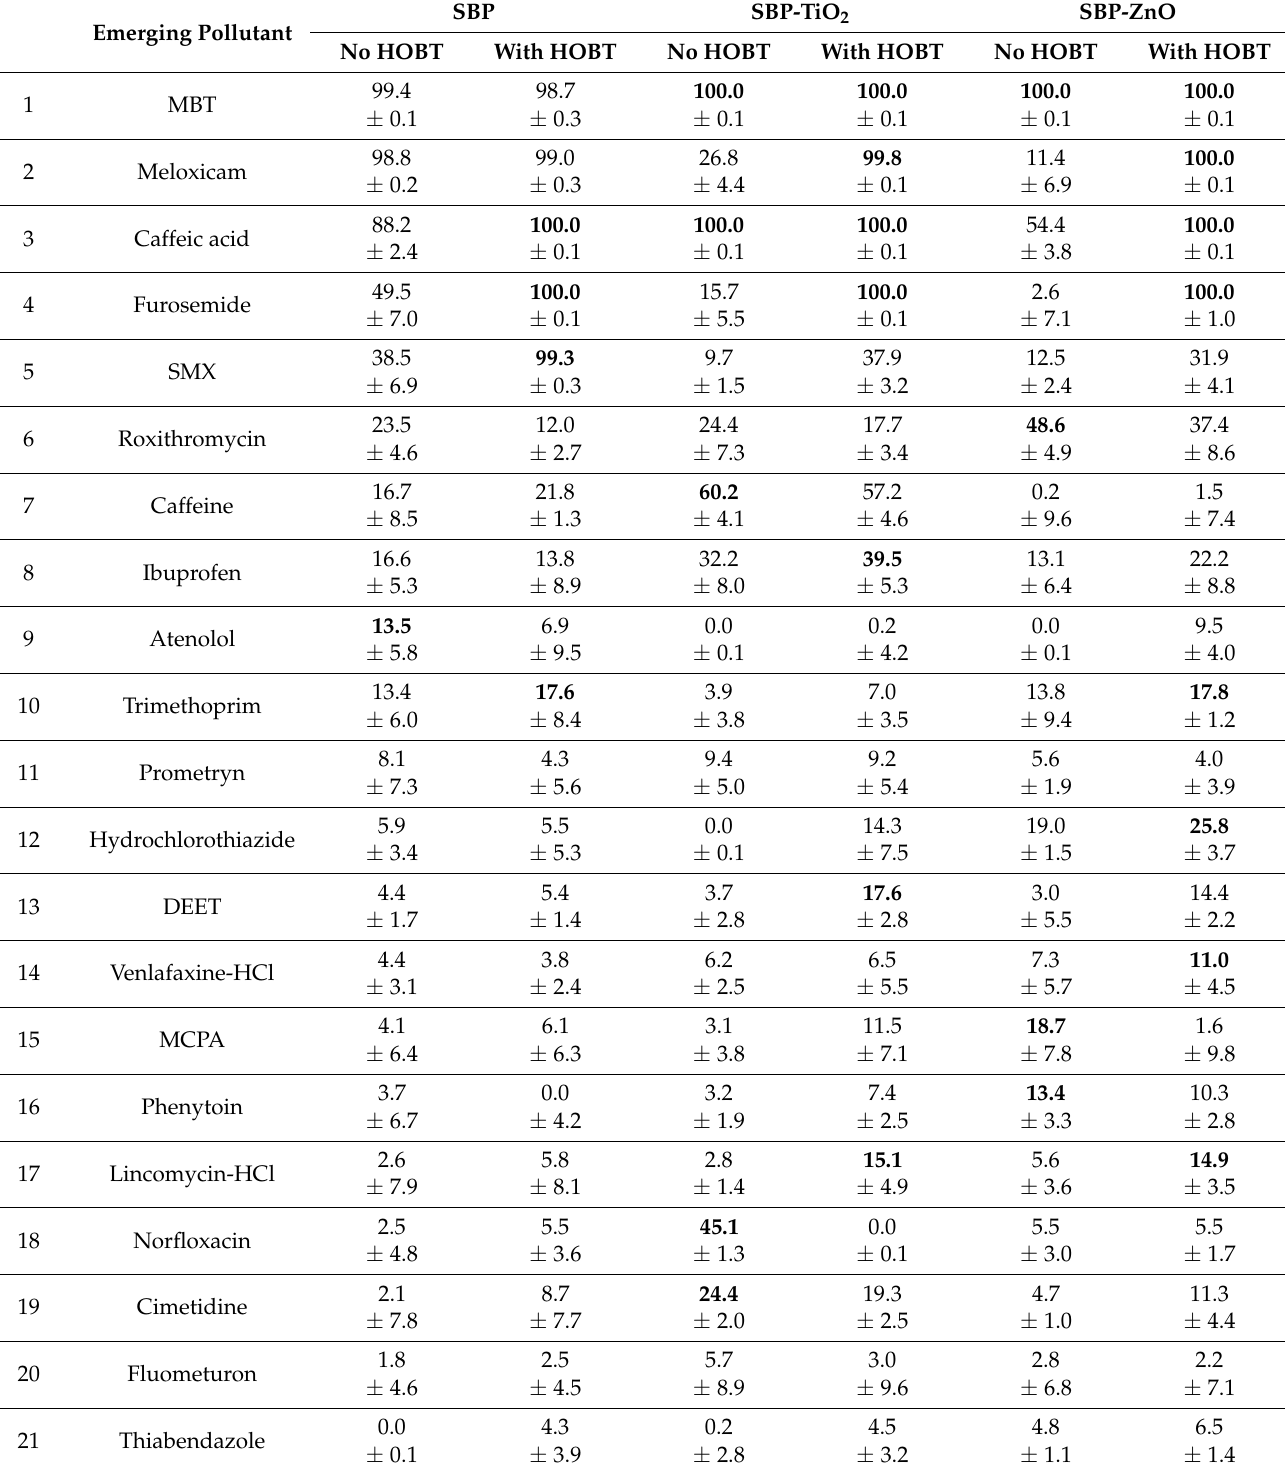
Table 4. Summary of % degradation data when a mixture of 21 Eps was treated with free SBP and immobilized SBP (TiO 2 - SBP and ZnO-SBP). The values in bold show the highest degradation obtained by either the free enzyme or immobilized